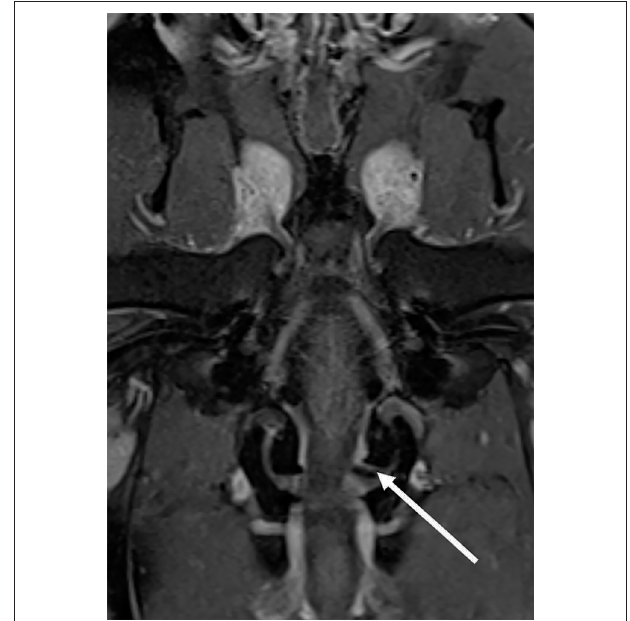
FIGURE 4 | Leukoencephalopathy in a snow leopard. (A) On this normal transverse T2-W image of the brain in a different leopard, the centrally located finger-like white matter tracts are hypointese to gray matter. (B) In the affected leopard the white matter tracts are diffusely T2 hyperintense. (C,D) Magnification of the T2-W MRI image paired with the corresponding histopathology image, which shows severe pallor and loss of cerebral white matter. Courtesy of Dr. Mee-Ja Sula.